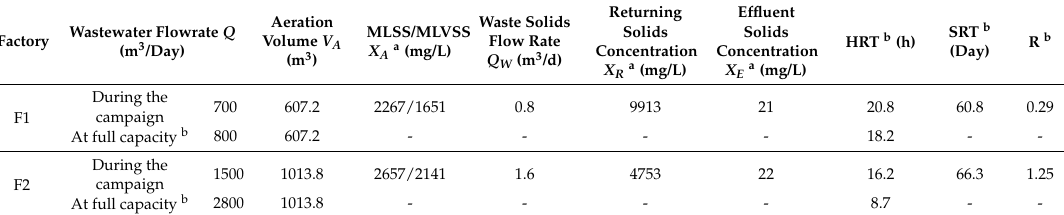
Table 2. Design and operating figures of the WWTPs of Hoa Sen and Chyang Sheng